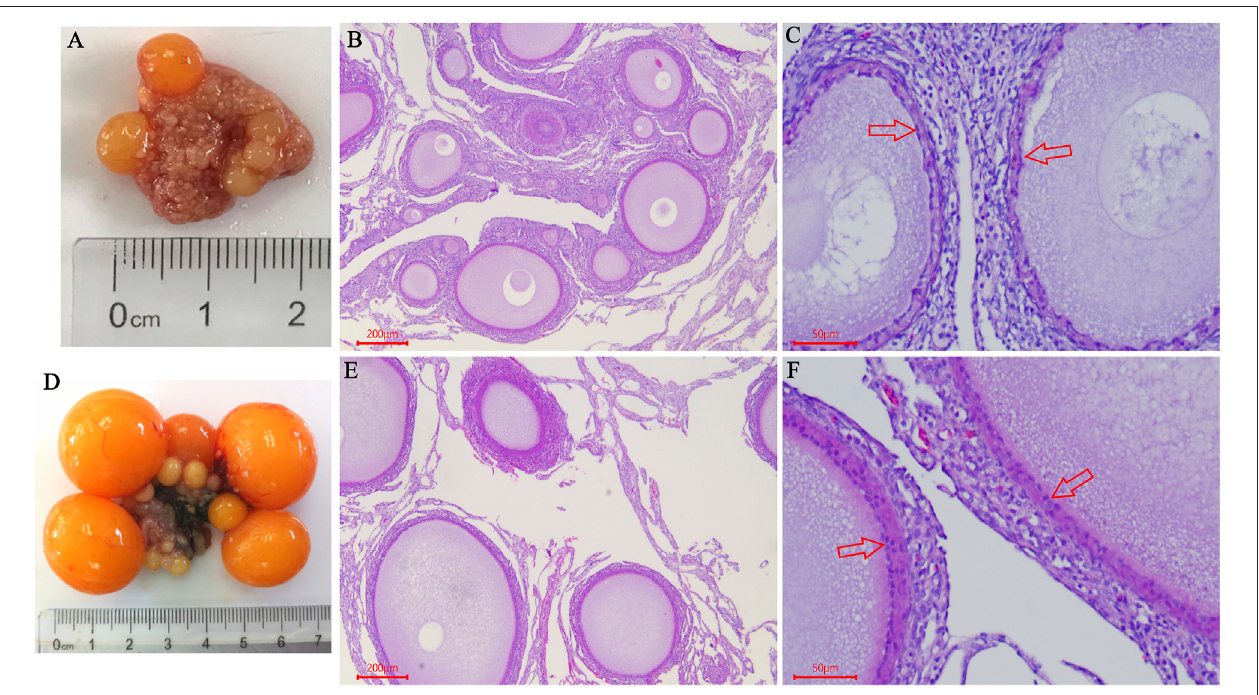
FIGURE1| Comparisonofovarianmorphologicalandhistologicalcharacteristicsbetweenpre-laying-hensandlaying-hens. (A) ChickenovaryontheageofD125; (B,C) HE staining of chicken ovary on the age of D125 (B 40×, C 200×); (D) Chicken ovary on the age of D139; (E,F) HE staining of chicken ovary on the age of D139 (B 40×, C 200×); red arrow indicates the “ granulosa cells ”